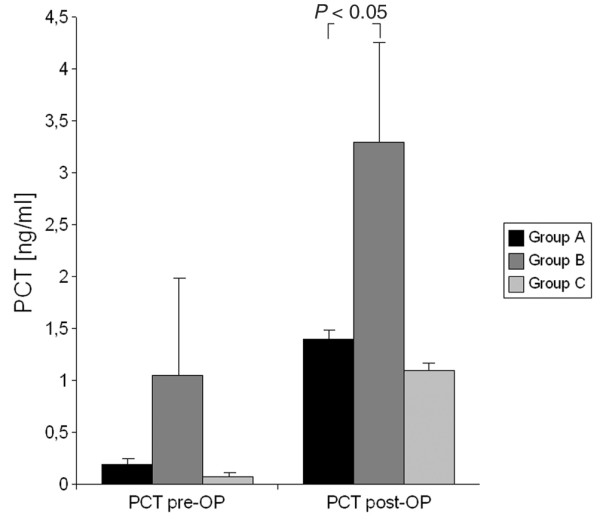
Comparison of pre- and postoperative serum-PCT in group A, B and C patients. Preoperative (pre-OP) and postoperative (post-OP) procalcitonin (PCT) serum levels in patients with no postoperative infections (group A), with postoperative infections (group B) and with postoperative infections after a defined event (group C). Error bars indicate the standard error of the mean.